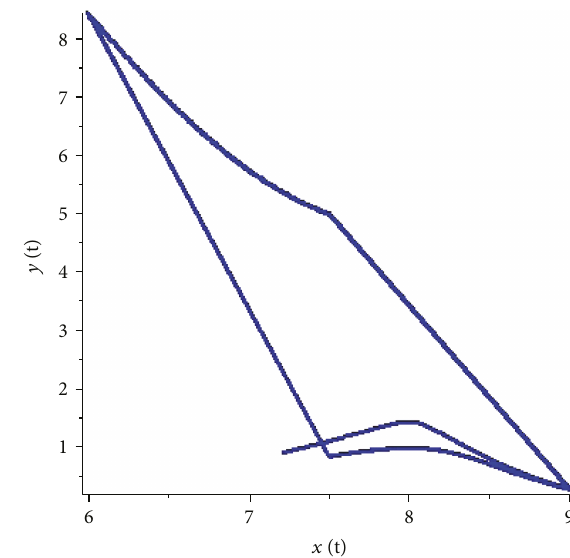
Figure 18: There exists an order-1 periodic solution in system (16) with q 1 = 1/6 , p = 0 8 , and τ = 4 7 .